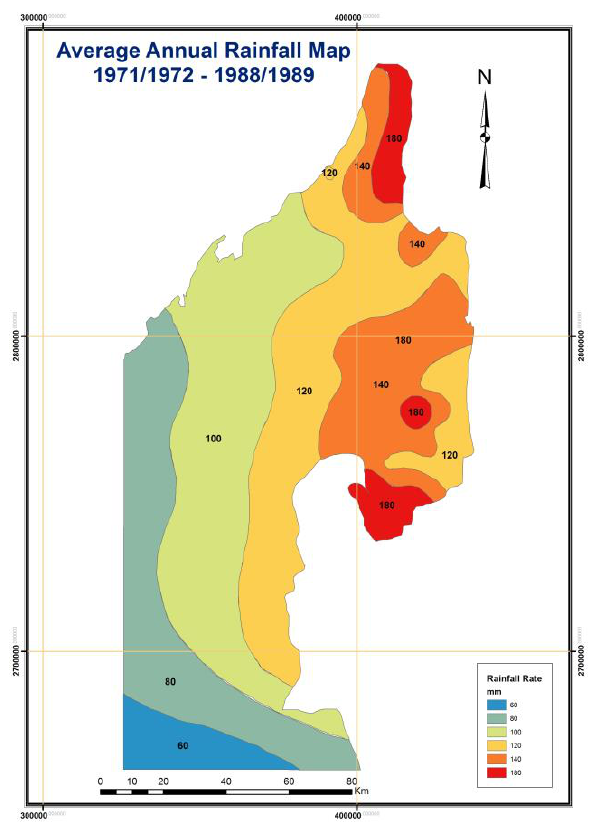
Figure 2. Average rainfall map for the Northern part of UAE. Slope is the measure of steepness or the degree of inclination of a feature relative to the horizontal plane. It can be derived from topographic and contour maps as well as digital elevation model (DEM). A 30 DEM (USGS Source) was used to derive the slope map for the study area and classified into five classes (0- 1.52), (1.53-4.38), (4.39-8.56), (8.57-13.89), (13.90-48.33), Figure